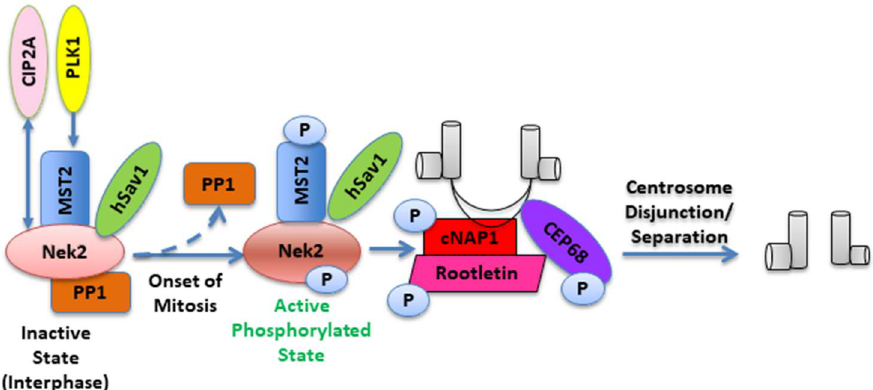
Figure 2. Role of upstream signal transduction regulators of Nek2 kinase in centrosome disjunction and separation. During interphase stage of the cell cycle, Nek2 remains in an inactive state as a complex of PP1 and hippo pathway regulators MST2/hSav1 via SARAH domain interactions (Mardin, Fry, Nature Cell Biology 2010); this is mediated through PP1 dephosphorylation antagonism. At the onset of mitosis, activated PLK1 phosphorylates MST2 kinase, thereby releasing the PP1 antagonism switch and promoting active phosphorylated Nek2 kinase enrichment at the centrosome. Active Nek2 then phosphorylates centrosome linker proteins, cNAP1 and rootletin, and mediates centrosome disjunction and separation. Another important regulator of Nek2 kinase is CIP2A, which directly binds and enhances Nek2 activity, independent of PP1 involvement.